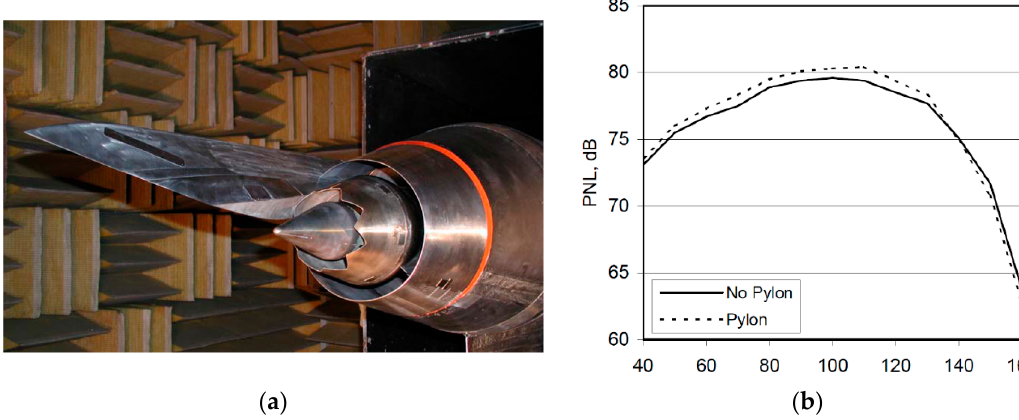
Figure 1. ( a ) Pylon installed on the separate exhaust nozzle (scale factor of 9). ( b ) perceived noise